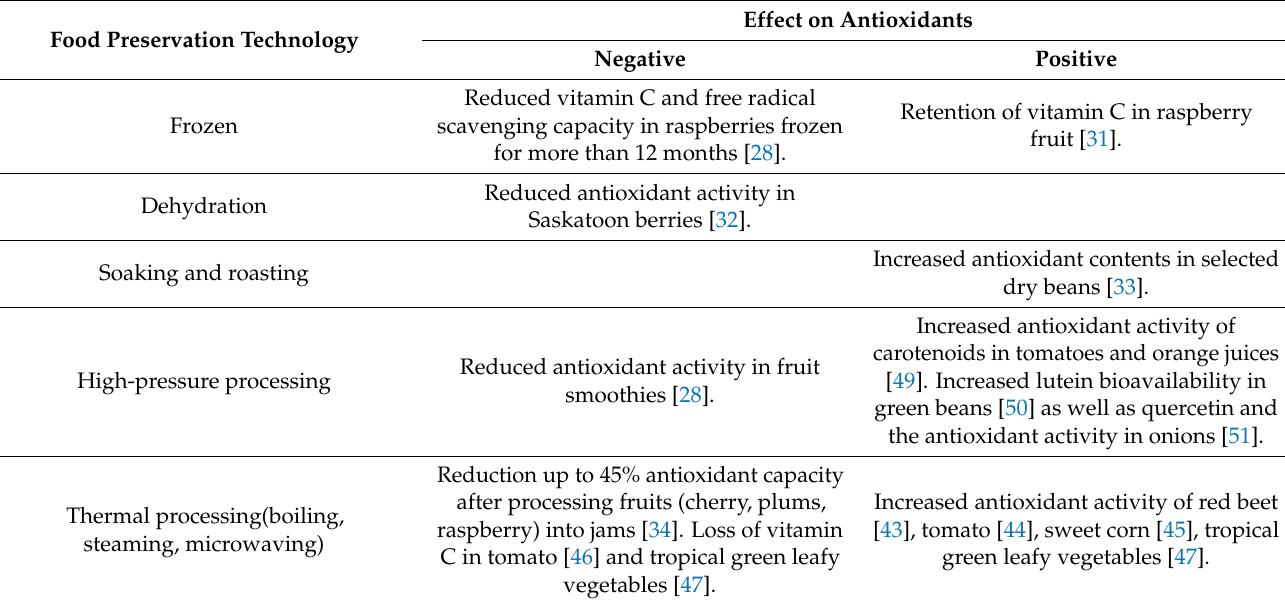
Table 1. Food preservation technology can increase, decrease or fail to affect the food’s antioxidant activity. Food Preservation